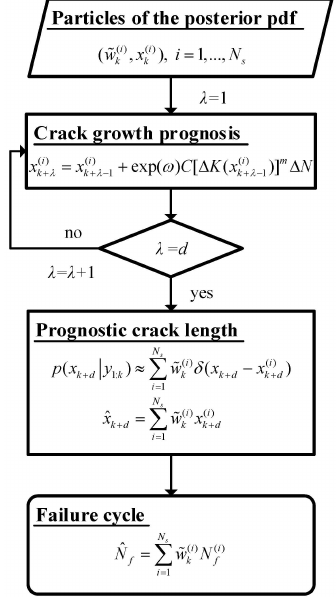
Figure 5. Flow chart of the prognosis for the crack propagation and failure